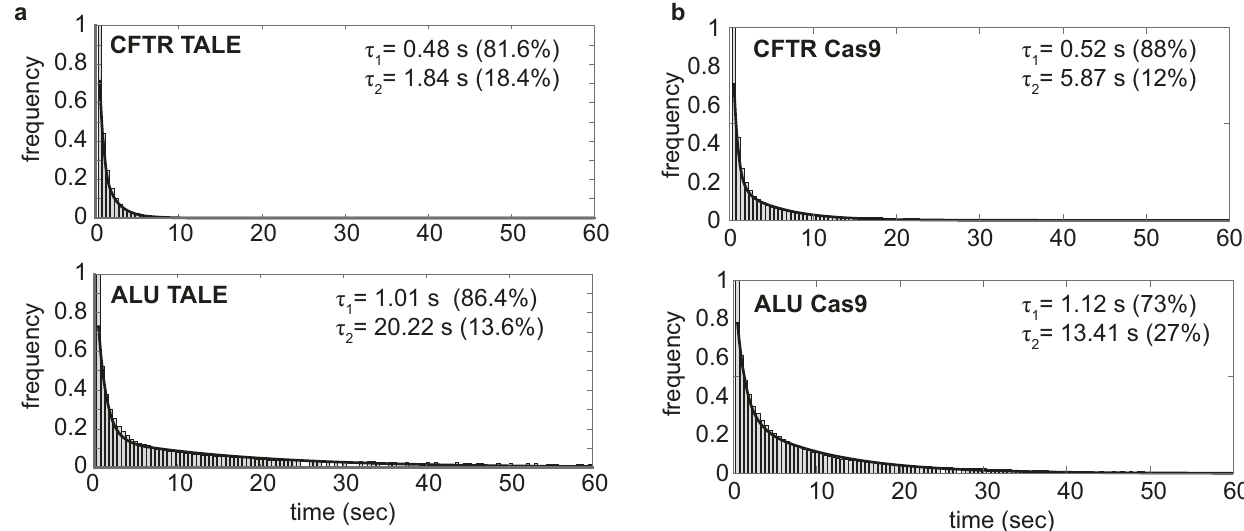
Fig. 2 Residence times of TALE and dCas9 on chromatin. a Residence times of TALE proteins in the large exposure time (500 ms) movies are plotted and fi tted to the double-exponential decay function. Large exposure time movies only capture the molecules that are bound to the genome. The top and bottom fi gures show the residence times of CFTR TALE and Alu TALE, respectively. Plots also show the characteristic residence times of each of the two populations ( τ 1 and τ 2 ) and the corresponding population percentages (in brackets). N CFTR TALE = 1373 and N Alu TALE = 1918, where N represents the number of data points. b Residence time histograms of CFTR and Alu dCas9 are shown. Similar to TALE histograms, characteristic timescales of and corresponding populations of dCas9 proteins are also shown. N CFTR Cas9 = 2159 and N Alu Cas9 = 3638. Source data are provided as a Source Data fi